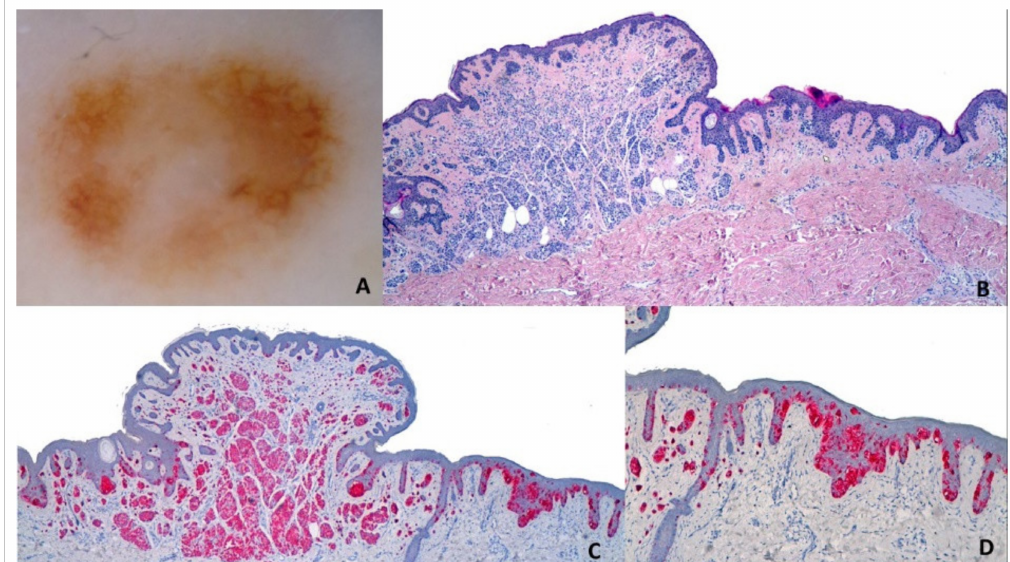
Figure 4. Nevus-associated melanoma in a 76-y old woman on the right buttock. Polarized contact dermoscopy (Panel A ; Dermalite ProHR ® , 3Gen, San Juan Capistrano, CA, USA) shows an asymmetric lesion with central hypopigmented-brown structureless areas and an atypical network on the right side. Histology shows an asymmetric melanocytic lesion composed on the left side by a dermal proliferation of monomorphous melanocytes with maturation (corresponding to the central hypopigmented-brown-structureless areas) and on the right shoulder elongated rete-ridges with atypical melanocytes in single units and irregular nests in all the epidermal layers, correlating to the atypical network (Panel B ; HE: 20 × ). The Melan-A staining highlights the pagetoid spread (Panel C : × 20; Panel D : 200 ×